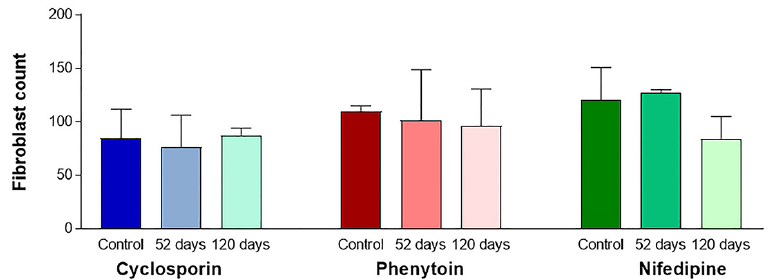
Figure 2- Fibroblast-like cell counting at days 0 (Control), 52 and 120. Medium values of three areas with 600.000 m m 2 : subjacent to oral epithelium, sulcular epithelium and middle-deep